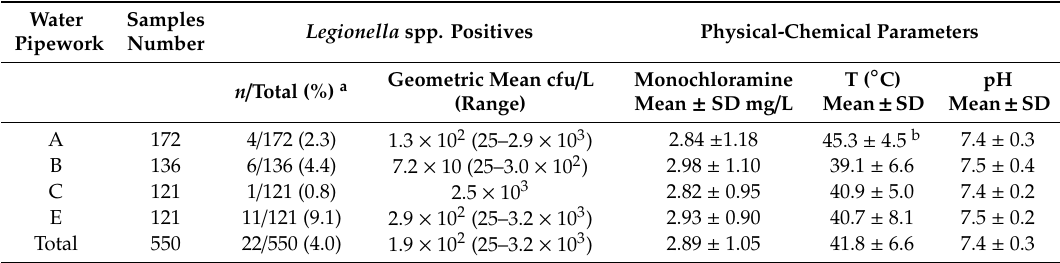
Table 1. Microbiological and physical–chemical parameters in water samples collected from the four monochloramine-treated networks.